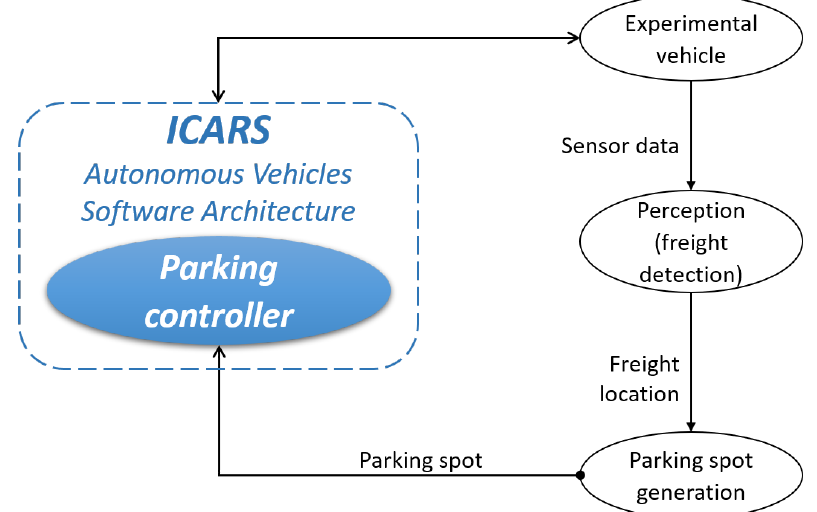
Figure 5. FURBOT software architecture.